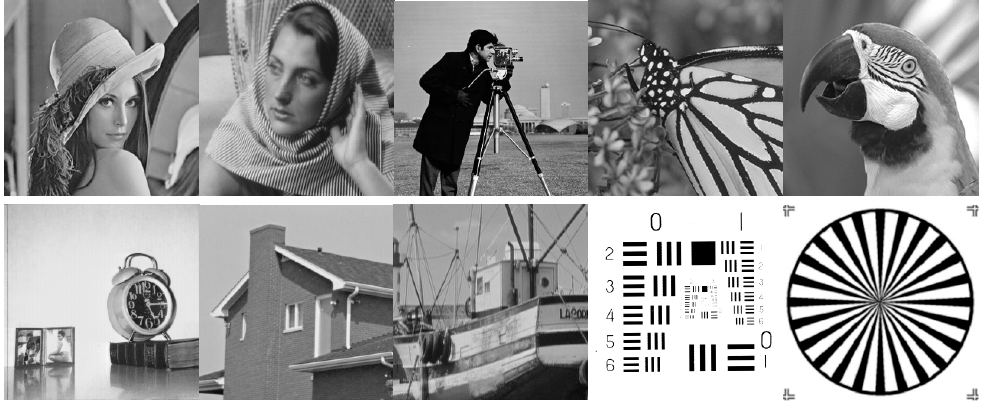
Figure 2. The original images.